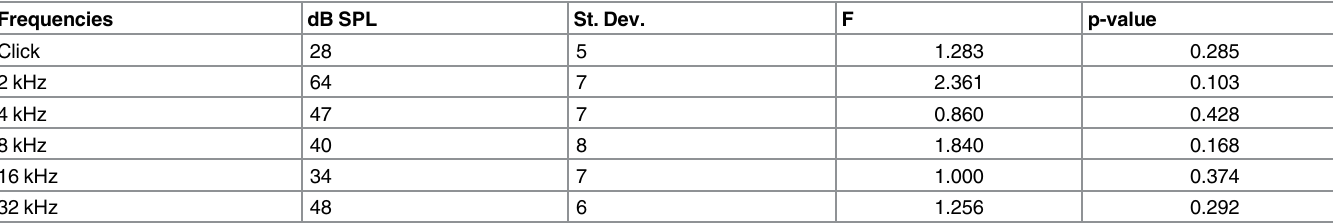
Table 1. ABR threshold averages, expressed as sound pressure level decibel (dB SPL) at day 0. Frequencies dB SPL St. Dev.